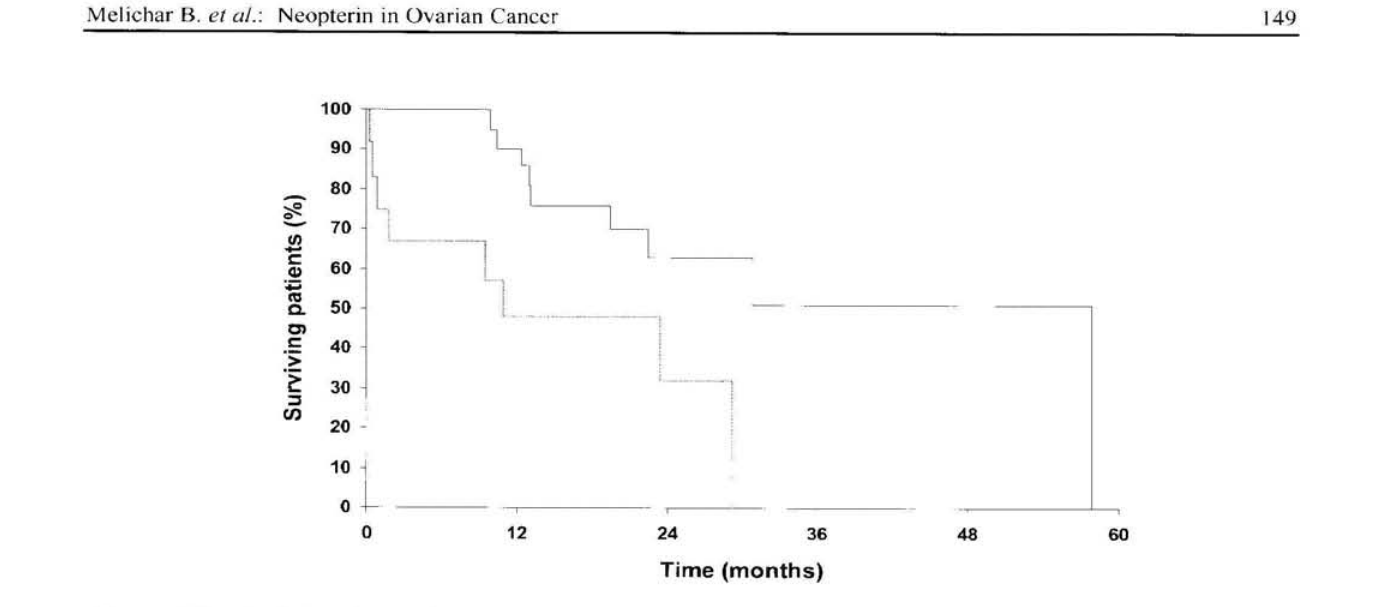
Figure 4. Survival of patients with primary ovarian cancer and urinary neopterin below 338 pmol/mol creatinine (black line) and equal or above 338 μιηοΐ/rnol creatinine (light line; ρ = 0.02; log-rank test).